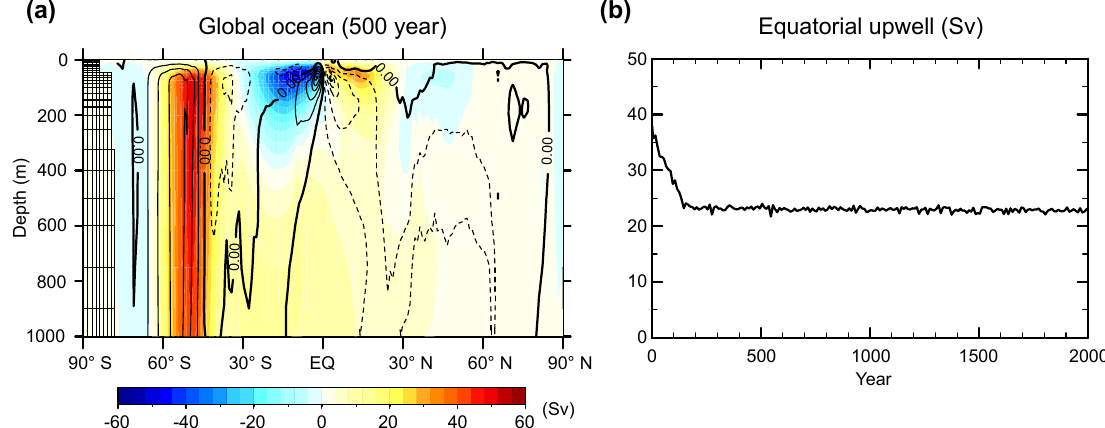
Figure 7. Global upper-ocean overturning circulation. (a) Meridional overturning stream function at year 500 (colors). The positive numbers represent clockwise circulation, and the negative numbers represent counterclockwise circulation. The contours show the differences between the meridional overturning stream function in year 500 and the preindustrial condition. The contour interval is 4Sv. (b) Time series of global equatorial upwelling (through 200m, between 10 ◦ S and 10 ◦ N)